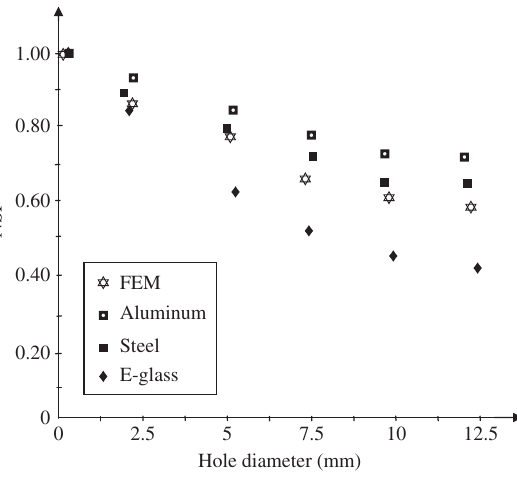
Figure 6 Comparison of NSF in compression for bonded